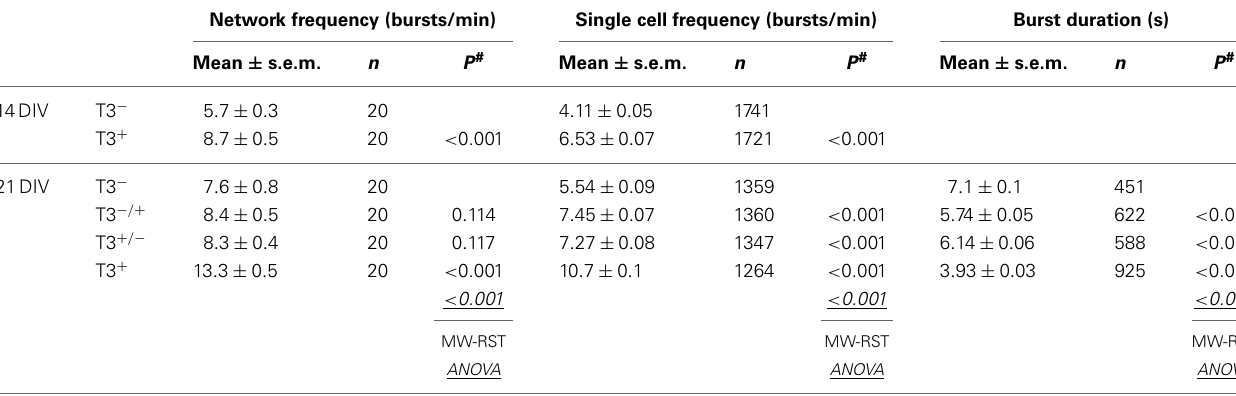
Table 1 | Summary of spontaneous activity imaging recordings of 14- and 21-day-old networks. Network frequency (bursts/min) Single cell frequency (bursts/min) Burst duration (s) Mean ±